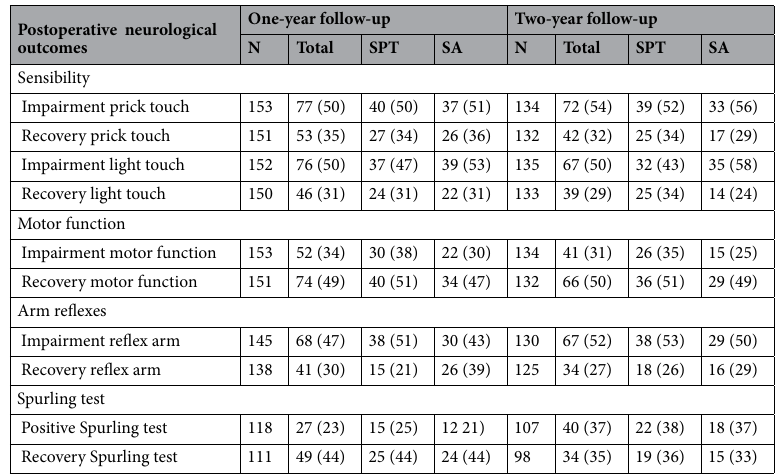
Table 2. Prevalence of persistent neurological impairments and neurological recovery at one- and two-year follow-up in participants with cervical radiculopathy who underwent surgery and postoperative rehabilitation. Results are presented with number (n) and percentage (%) as n (%). Persistent neurological impairments includes patients presenting at least one abnormal response, and neurological recovery includes patients with preoperative impairment presenting normal neurology at follow-up.